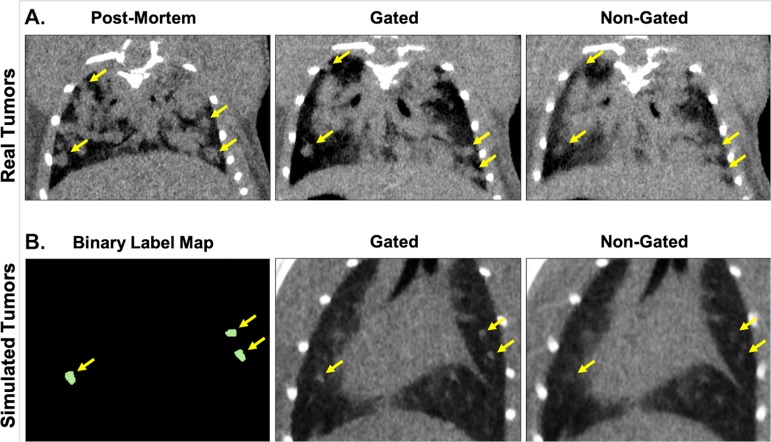
Demonstration of simulated lung tumor images compared to in vivo images of tumor-bearing lungs.In vivo lung images from a tumor-bearing mouse demonstrate the difference between non-gated and gated images compared to post-mortem tumor detection (A). Simulated tumors are created from segmentations of real tumors, which are projected into the lungs of a healthy, free-breathing mouse (B). Simulated tumors mimic the appearance and location of tumors seen within in vivo images, as well as the effects of respiratory gating on tumor edge definition, but have the advantage of a binary label map which serves as “truth”. Real and simulated tumors are indicated with yellow arrows on in vivo and simulated acquisitions, respectively.